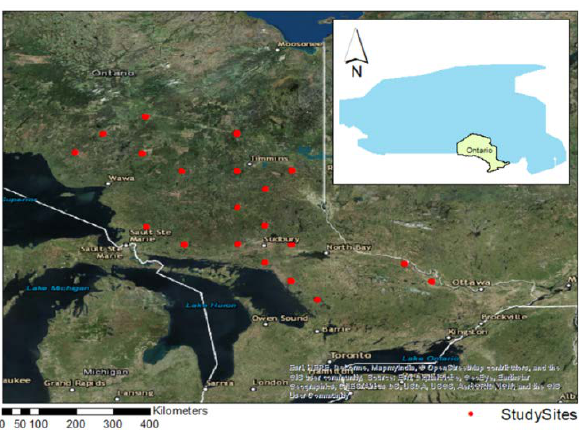
Figure 1. Study area. Red dots indicate the location of study sites. Five Radarsat-2 SAR quad-polarization imagery acquired in May of 2008,2009,2010, 2014, 2015, and 2016, in fine resolution mode with a spatial resolution of 5 m. Sigma Nought which is the backscatter returned to the antenna from a unit area on the ground is used to calibrate data for the local incidence angle to the ground range. All three SAR imagery was then converted from raw units to power units (decibels). The SPOT-7 imagery acquired on 03 May 2016 has four spectral bands, blue (450-520nm), green (530-590nm), red (625-695nm), and near-infrared (760-890), and a spatial resolution of 6.6 meters. The imagery has been ortho- rectified to be the same georeferenced as the SAR